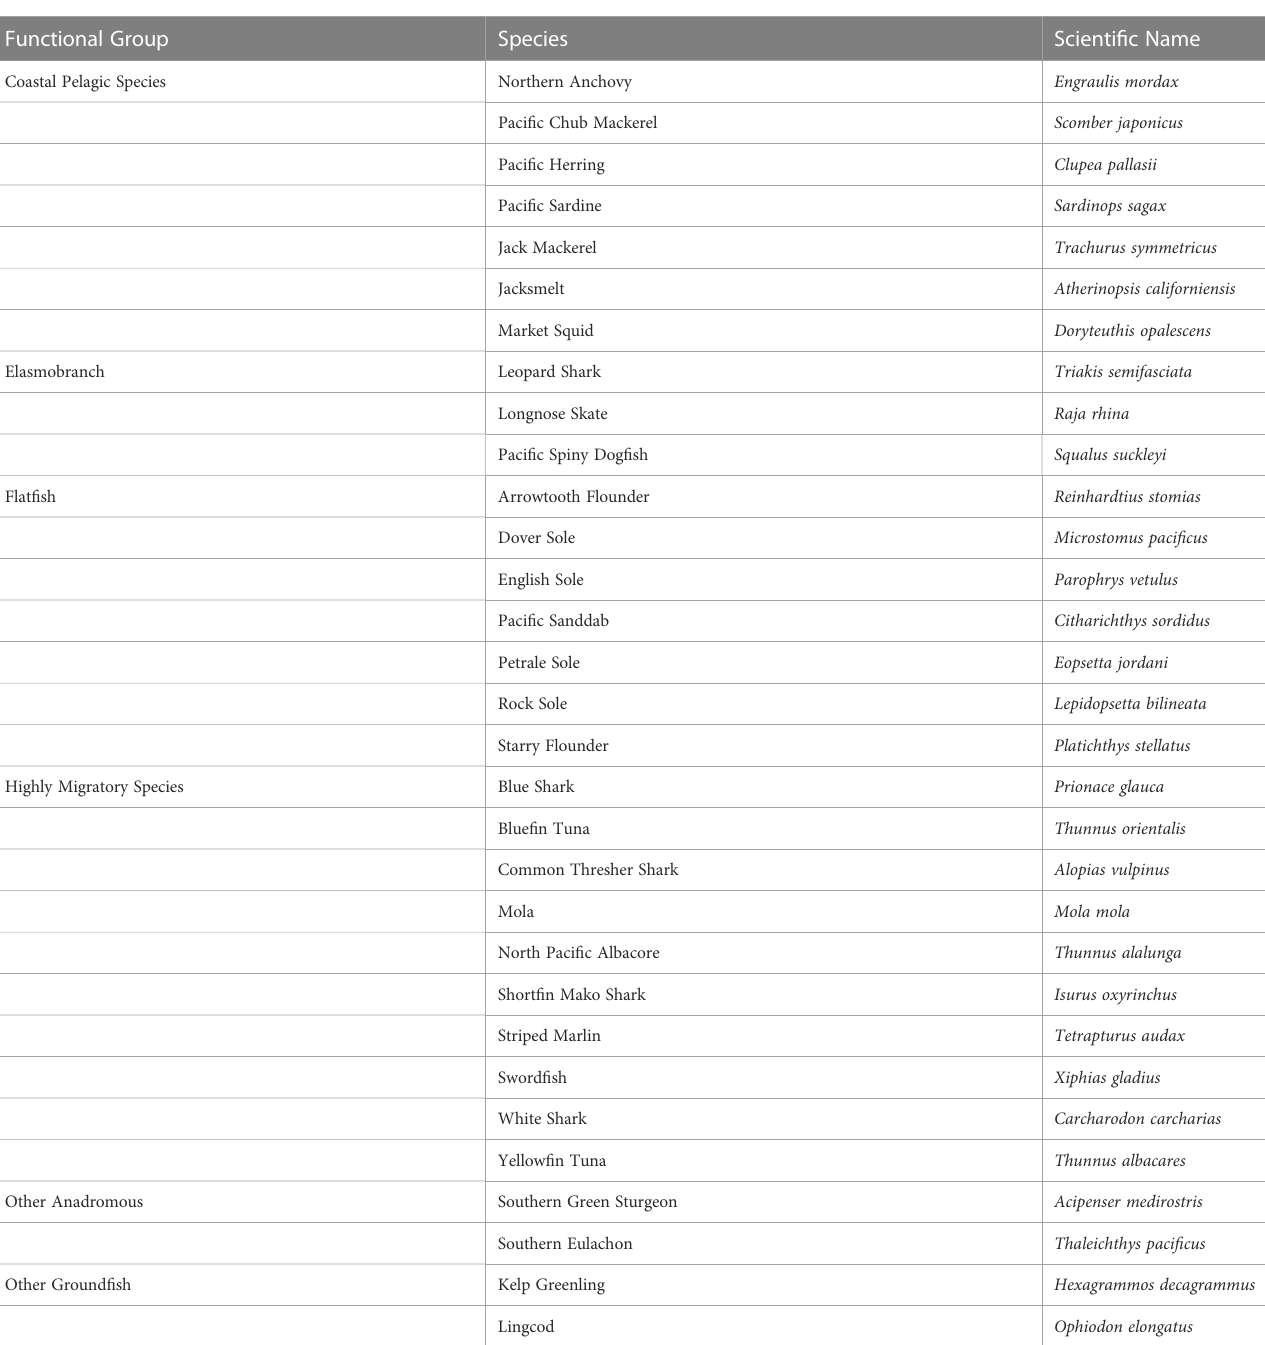
TABLE 1 List of species analyzed in this